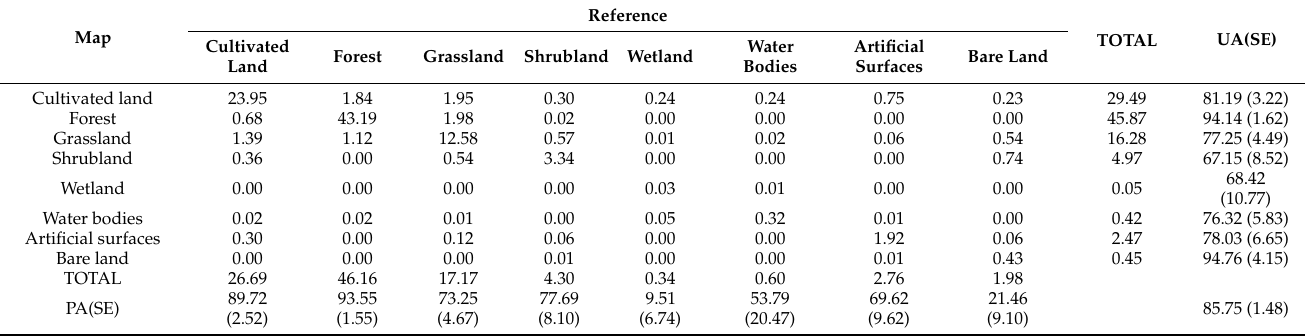
Table A11. Error matrix of fused product 2020 using modified Dempster–Shafer.